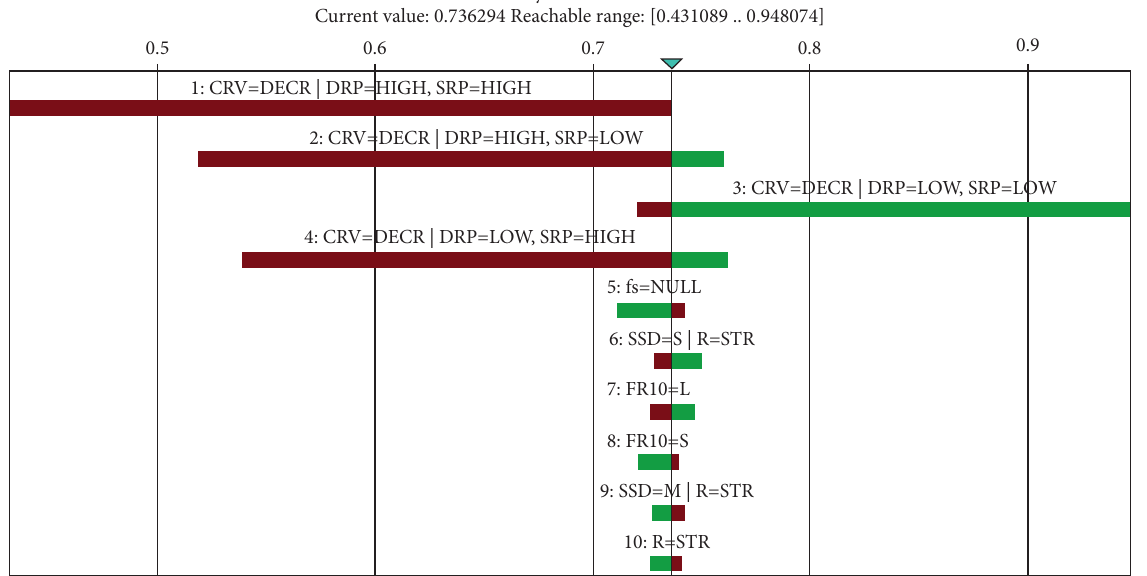
Figure 9: Sensitivity analysis of CRV (CRV �